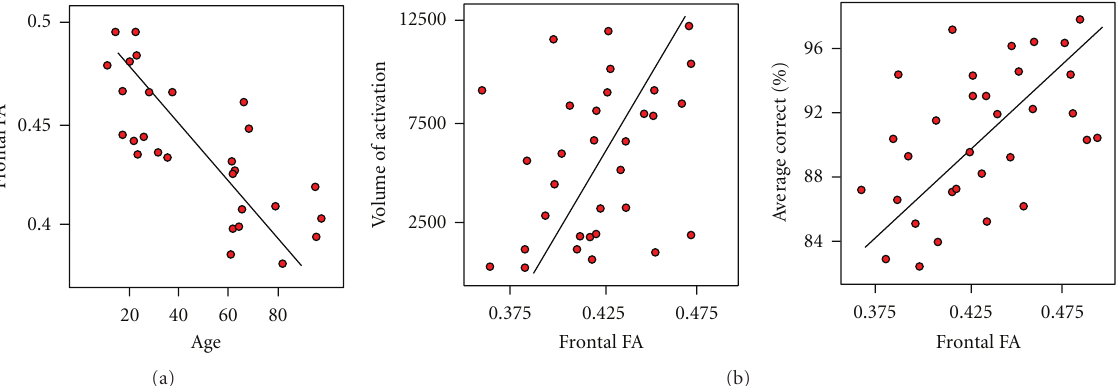
Figure 9: Scatterplots with best-fit lines indicating the relationship between age and FA (a), and FA with volume of activation and behavioral performance